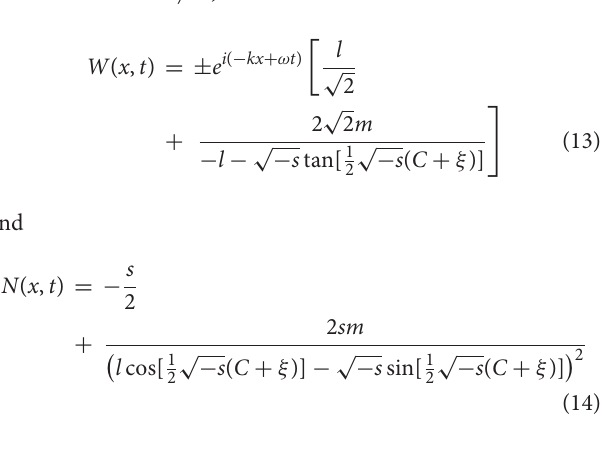
FIGURE 1 | 3D plots of and C =